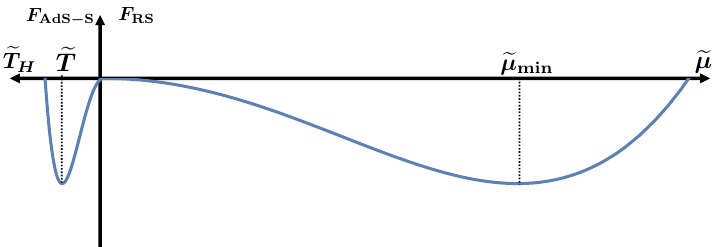
Figure 3 . The 4D potential of the AdS-S spacetime (left side of the axis) and the RS spacetime (right side of the axis) at the critical temperature T c . The canonically normalized Hawking tem- perature e T H ( x ) and the radion ~ (cid:22) ( x ) are the order parameters in the AdS-S spacetime and the RS spacetime, respectively. The two origins ~ (cid:22) = 0 and e T H = 0 must coincide with each other because they both correspond to the bulk AdS spacetime with the UV